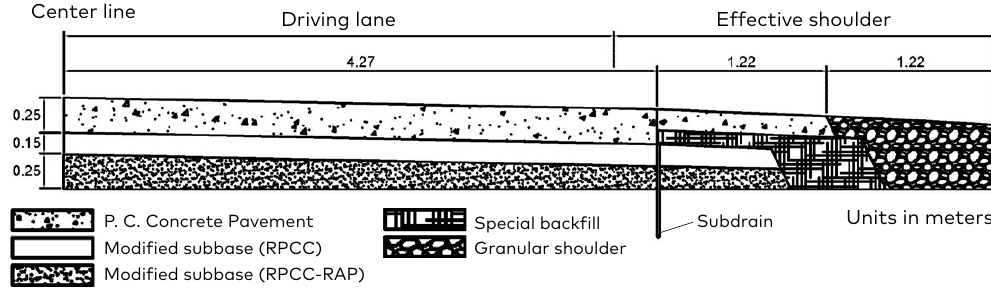
Figure 1. The reconstructed pavement and foundation layer